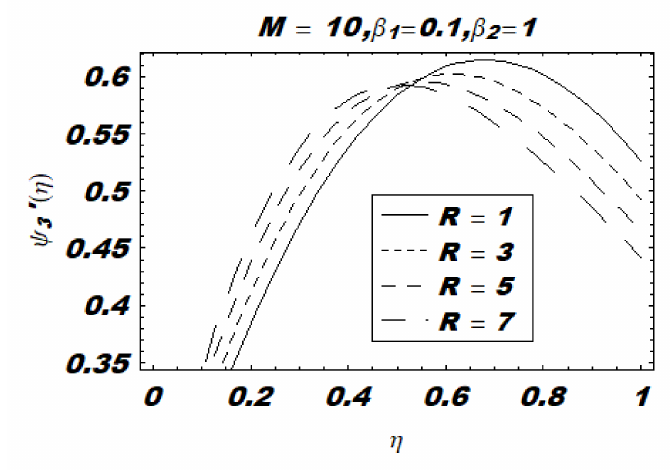
Figure 23. Similarity function ψ /